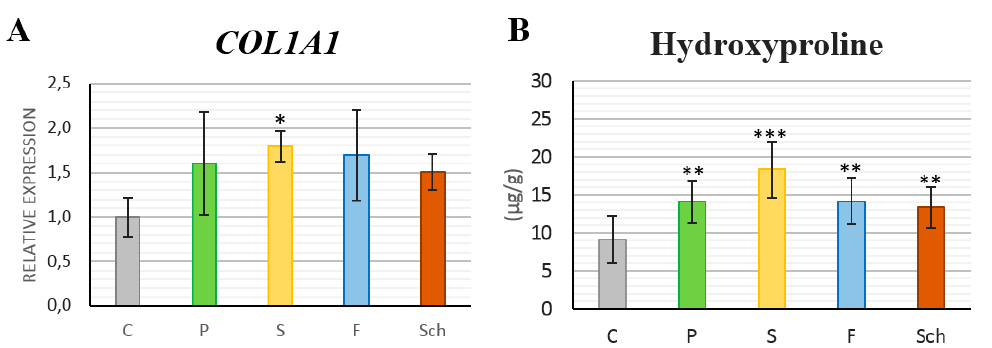
Figure 11. Gene expression of COL1A1 and hydroxyproline content in wound area. Control (C), palm oil (P), safflower oil (S), fish oil (F), and Schizochytrium extract (Sch) treated animals fed for 64 days were analyzed 12 days post-excision. ( A ): COL1A1 gene expression analyses. * labeled group of fatty acids, which differ significantly from the control group ( p < 0.05; unpaired t -test; n = 3). ( B ): Analysis of hydroxyproline content. Stars label group of fatty acids, which differ significantly from the control group (* p < 0.05; ** p < 0.01; *** p < 0.001, unpaired t -test; n = 10). Average values and standard deviations are displayed in both graph.